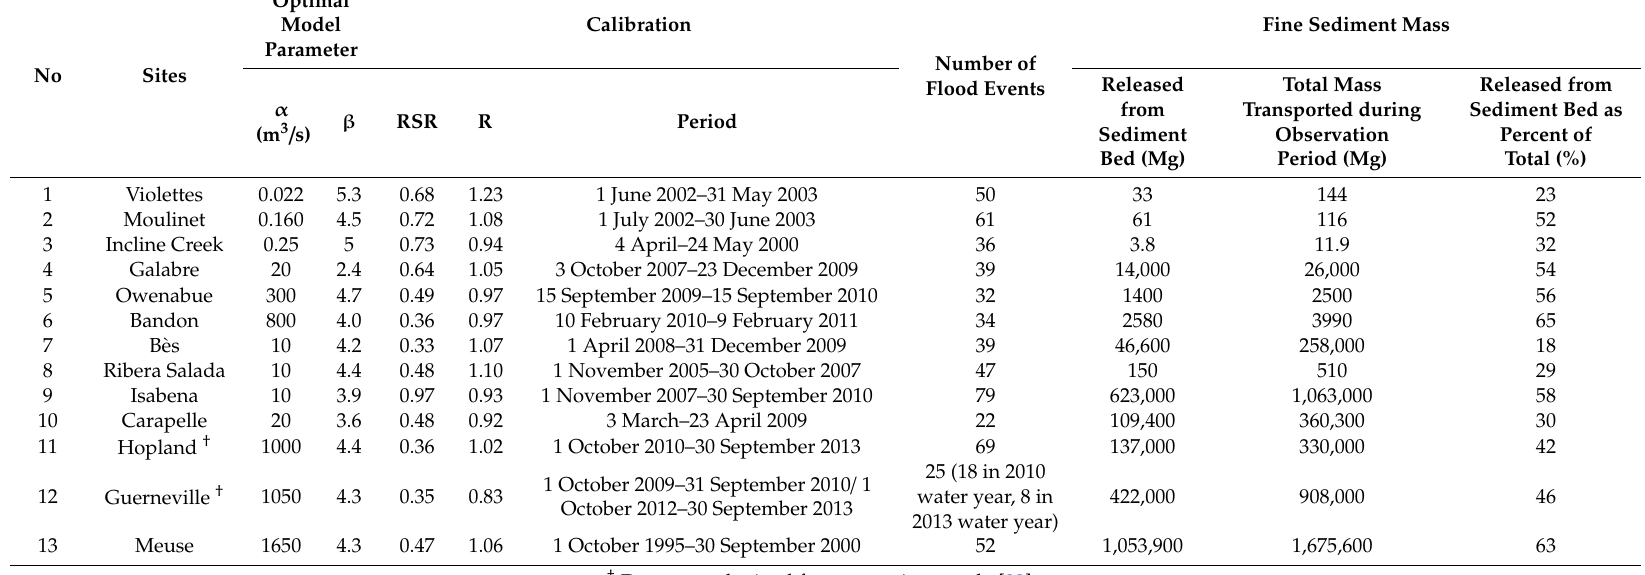
Table 2. Model calibration